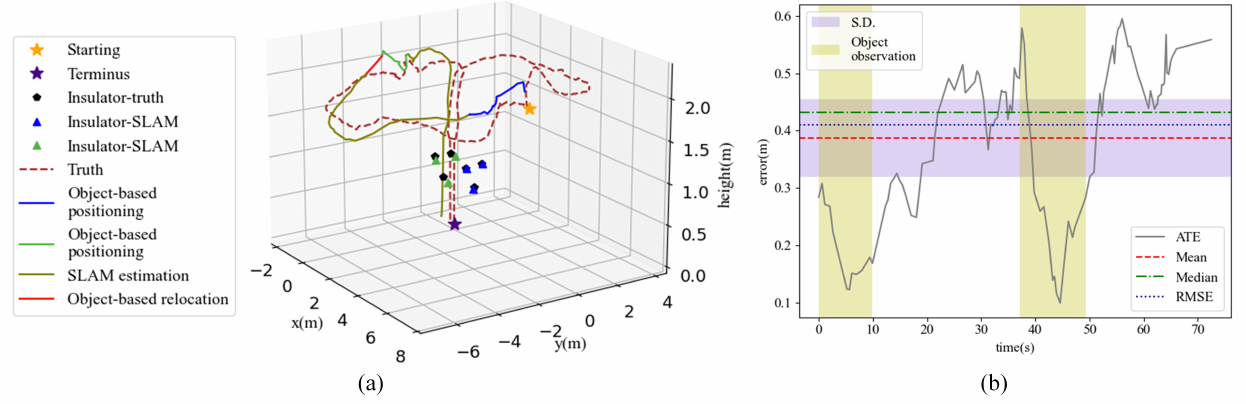
Figure 10. Object-based geographical UAV positioning. ( a ) The visualization of object-based UAV positioning. ( b ) The error